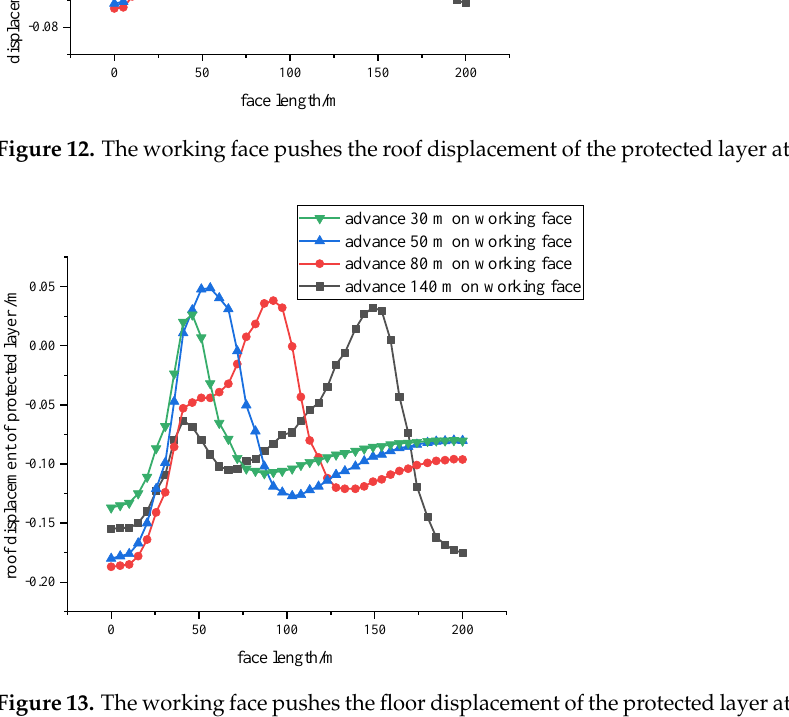
Figure 13. The working face pushes the floor displacement of the protected layer at different distances.